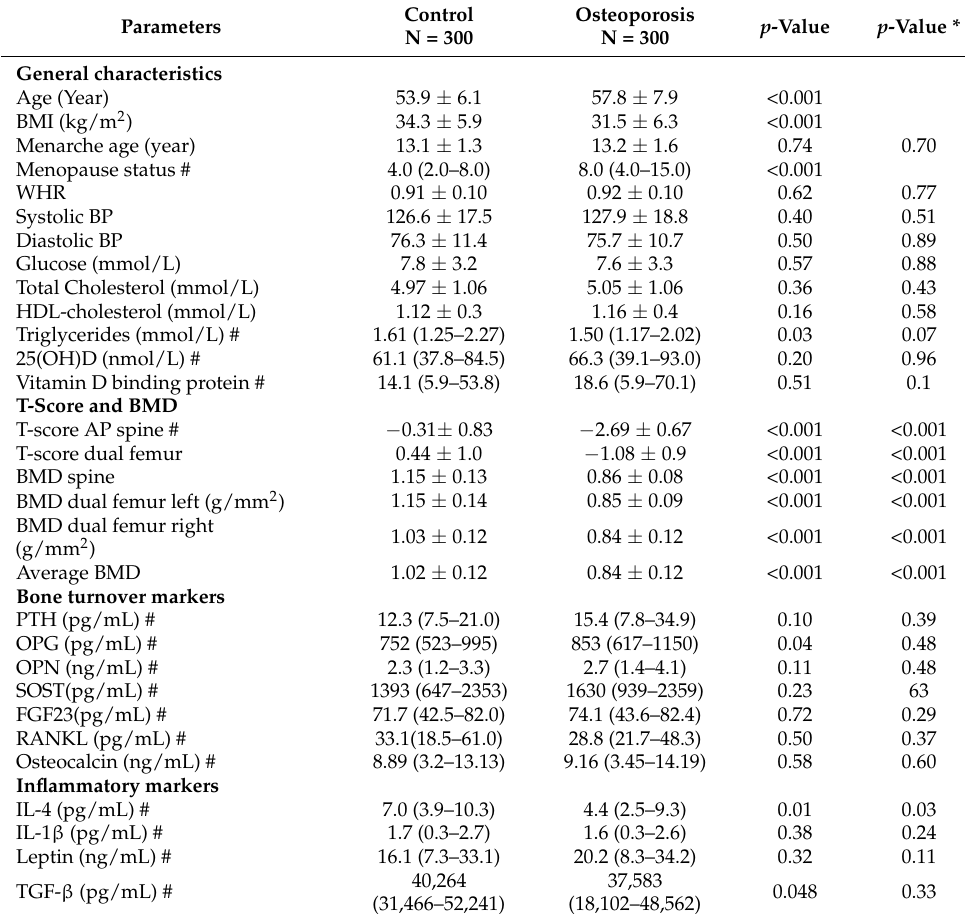
Table 1. Anthropometry and clinical characteristics of